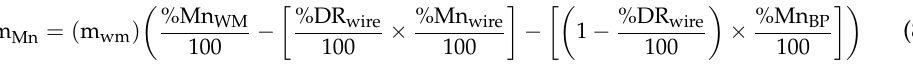
Figure 5. Solidification curves for MP1 and MP3 weld metal compositions (FactSage 7.3). Increased silicon and manganese content in the MP weld metal analyses in Table 3, as compared to the BC weld metal, confirms that SiO 2 and MnO were reduced from the molten flux by the added Al powder. The mass of Mn and Si added to the MP weld metals, relative to the BC weld metal nominal composition, was calculated from the weld metal mass and the dilution ratio values in Table 5, as illustrated in Equation (8) for Mn. The mass of Si added relative to the BC value may be calculated by using the %Si values, instead of the %Mn values, in Equation (8). The square bracketed terms of Equation (8) represent the calculation of the BC weld metal nominal composition.